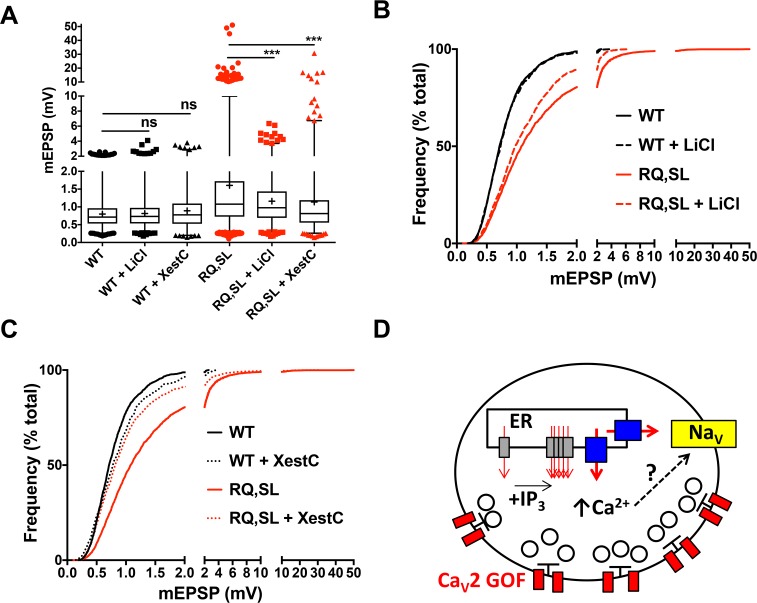
Pharmacological inhibition of intracellular Ca2+ release dampens gain-of-function phenotypes associated with FHM1-mimicking mutations.(A-C) Data displayed and analyzed as before. Box and whisker plots (A) and cumulative probability histograms (B, C) demonstrate that acute application of either LiCl (to block PIP2 recycling) or Xestospongin C (to block IP3 receptors) both suppress the gain-of-function spontaneous mEPSP phenotypes in RQ,SL-expressing NMJs. *** p < 0.001 by Kruskal-Wallis ANOVA with Dunn’s multiple comparisons test vs. RQ,SL alone. (D) Cartoon model depicting neuronal components implicated in this study of regulating neurophysiology downstream of migraine-mimicking amino-acid substitutions. Red–CaV2 channels; gray–IP3 receptors; blue–Ryanodine receptors; yellow–NaV channels.